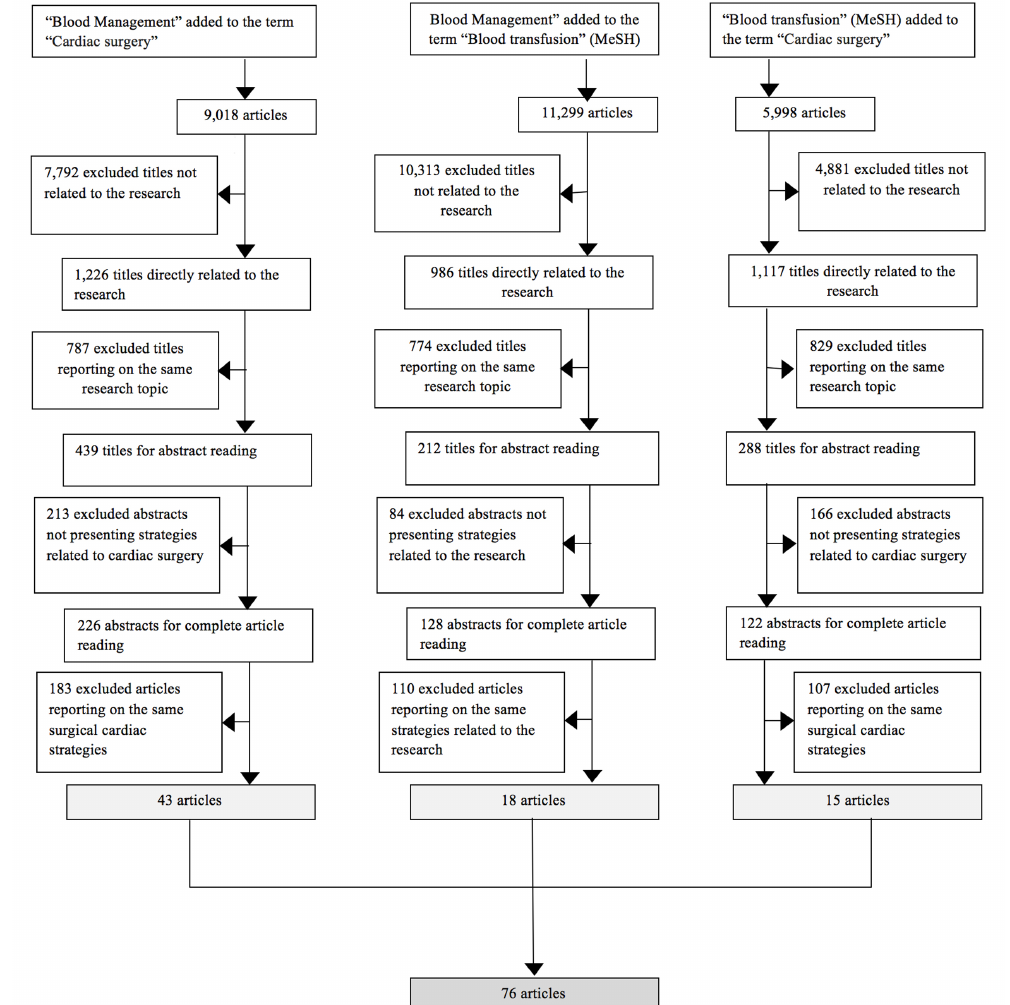
Fig. 1 - Organogram of the methodology about the different search steps. MeSH=Medical Subject